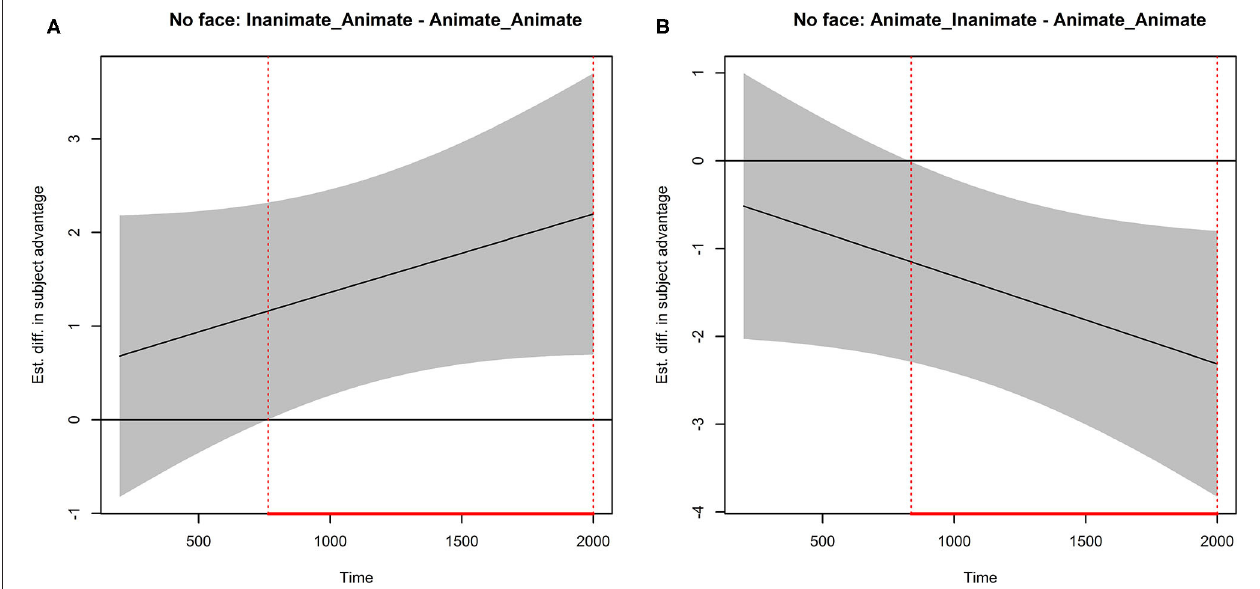
FIGURE 7 | Adult data sentence type difference curves calculated from model-predicted curves with 99% confidence bands. Vertical lines indicate time points for which zero is not included in the confidence bands. (A) Inanimate-animate minus animate-animate (NoFace conditions). (B) Animate-inanimate minus animate-animate (NoFace